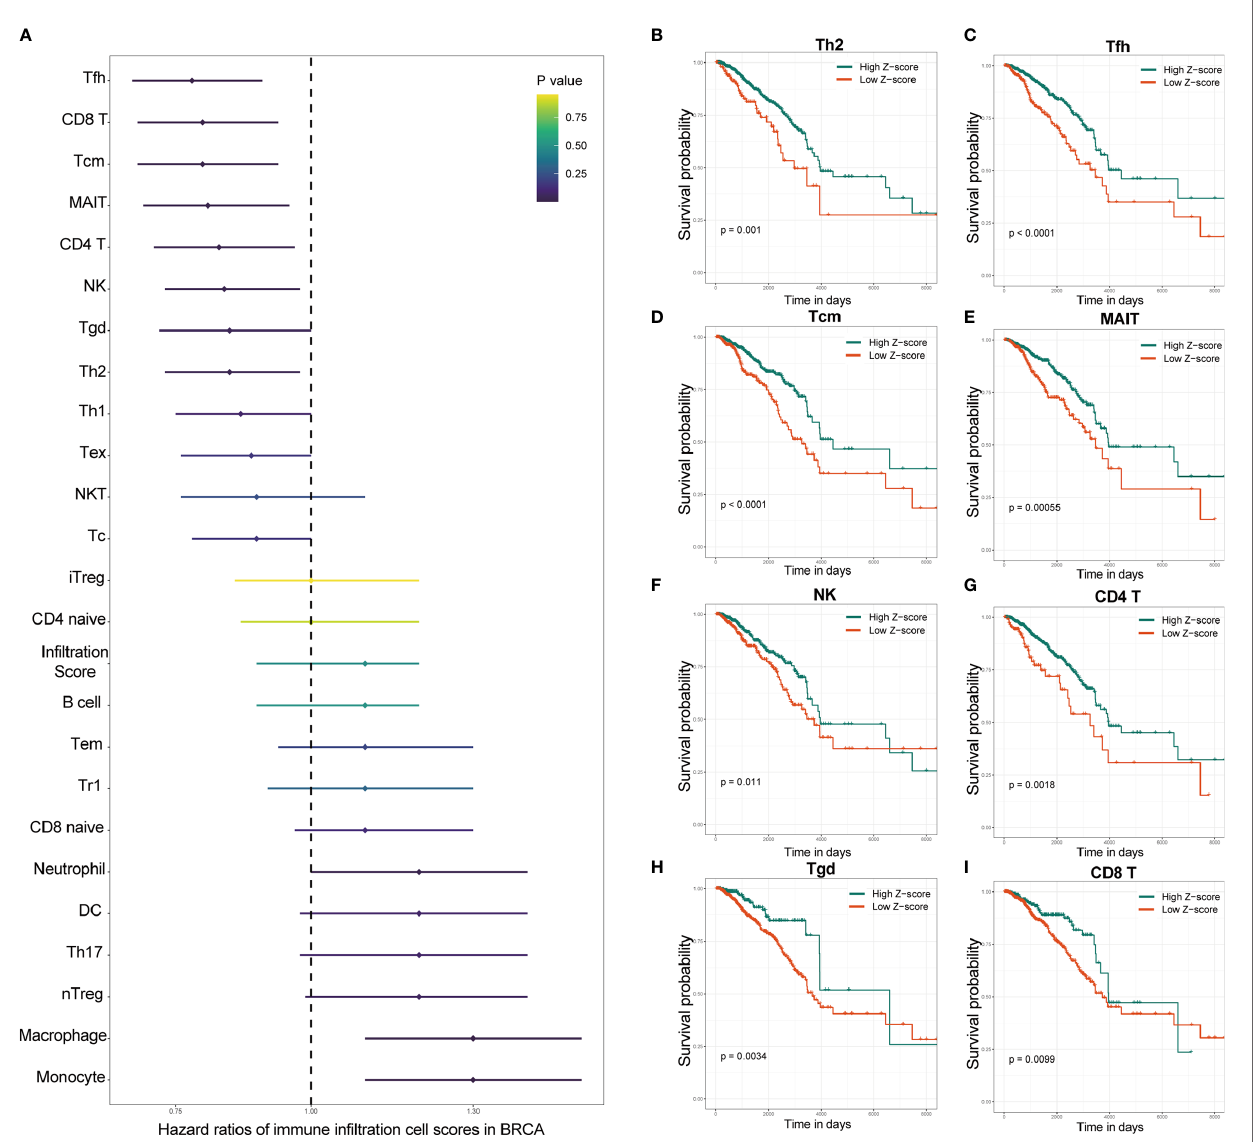
FIGURE 2 | Speci fi c immune cells were identi fi ed as protective factors for survival by the immune in fi ltration score. (A) Univariate Cox regression analysis showed that several of the various immune cells in breast cancer were major protective factors. Kaplan – Meier analysis showed that patients with higher immune in fi ltration scores of Th2 (B) , Tfh (C) , Tcm (D) , MAIT (E) , NK (F) , CD4 T (G) , Tgd (H) and CD8 T (I) cells exhibited better OS. OS, overall survival; IRS, immune in fi ltration- related score. NK cells, natural killer cells; Th2 cells, T helper 2 cells; Tfh cells, T helper cells; MAIT cells, mucosal-associated invariant T